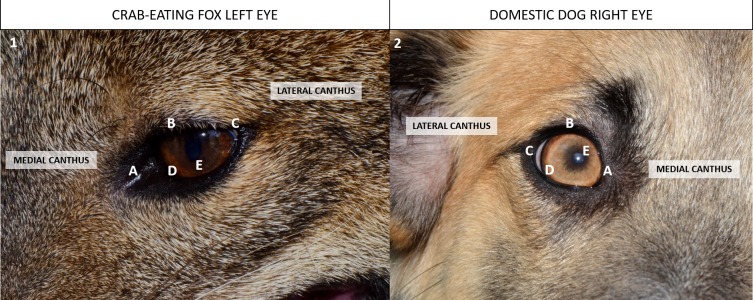
External view of crab-eating fox eye compared to canine eye.Completely pigmented upper and lower eyelids (A1 and A2), presence of cilia only on the upper eyelid (B1 and B2), minimal exposure of the slightly pigmented bulbar conjunctiva at the lateral canthus (C1 and C2), brown-colored iris (D1), and vertical subcircular-shaped pupil (E1). There are different colors of iris in dogs (D2) and a round pupil is observed (E2).